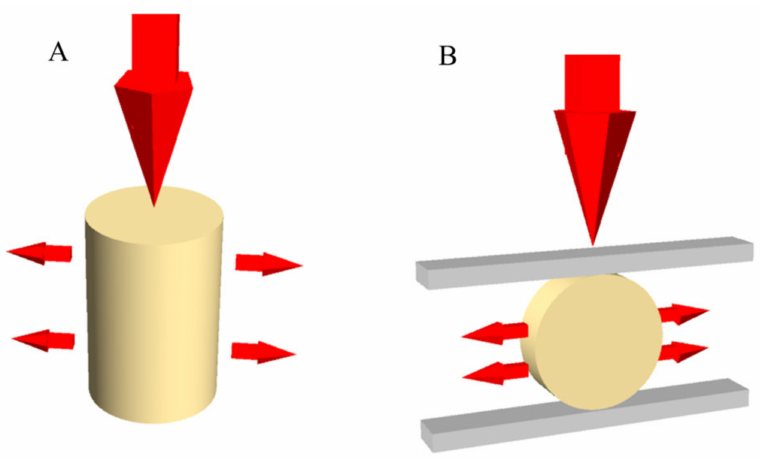
Figure 1. Schematic illustration of: ( A ) compressive strength test; and ( B ) diametral tensile strength test. After the initial reaction, the specimens were removed from the matrix, and the surfaces were protected with petroleum jelly. They were stored for 24 h in deionized